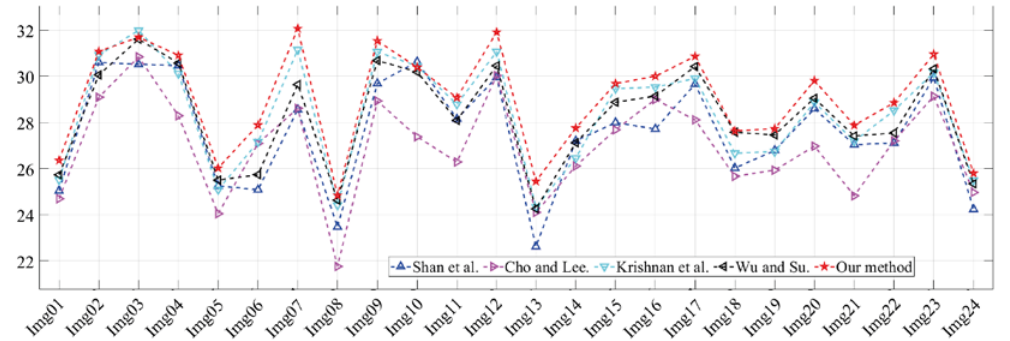
Figure 8. Statistics related to the average peak signal-to-noise ratios (PSNRs) for the comparison results of all the test images.